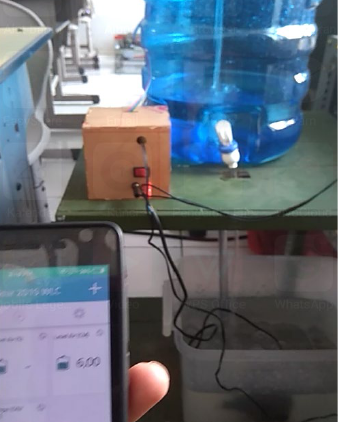
Figure 21. Setpoint Testing upper limit of 10cm